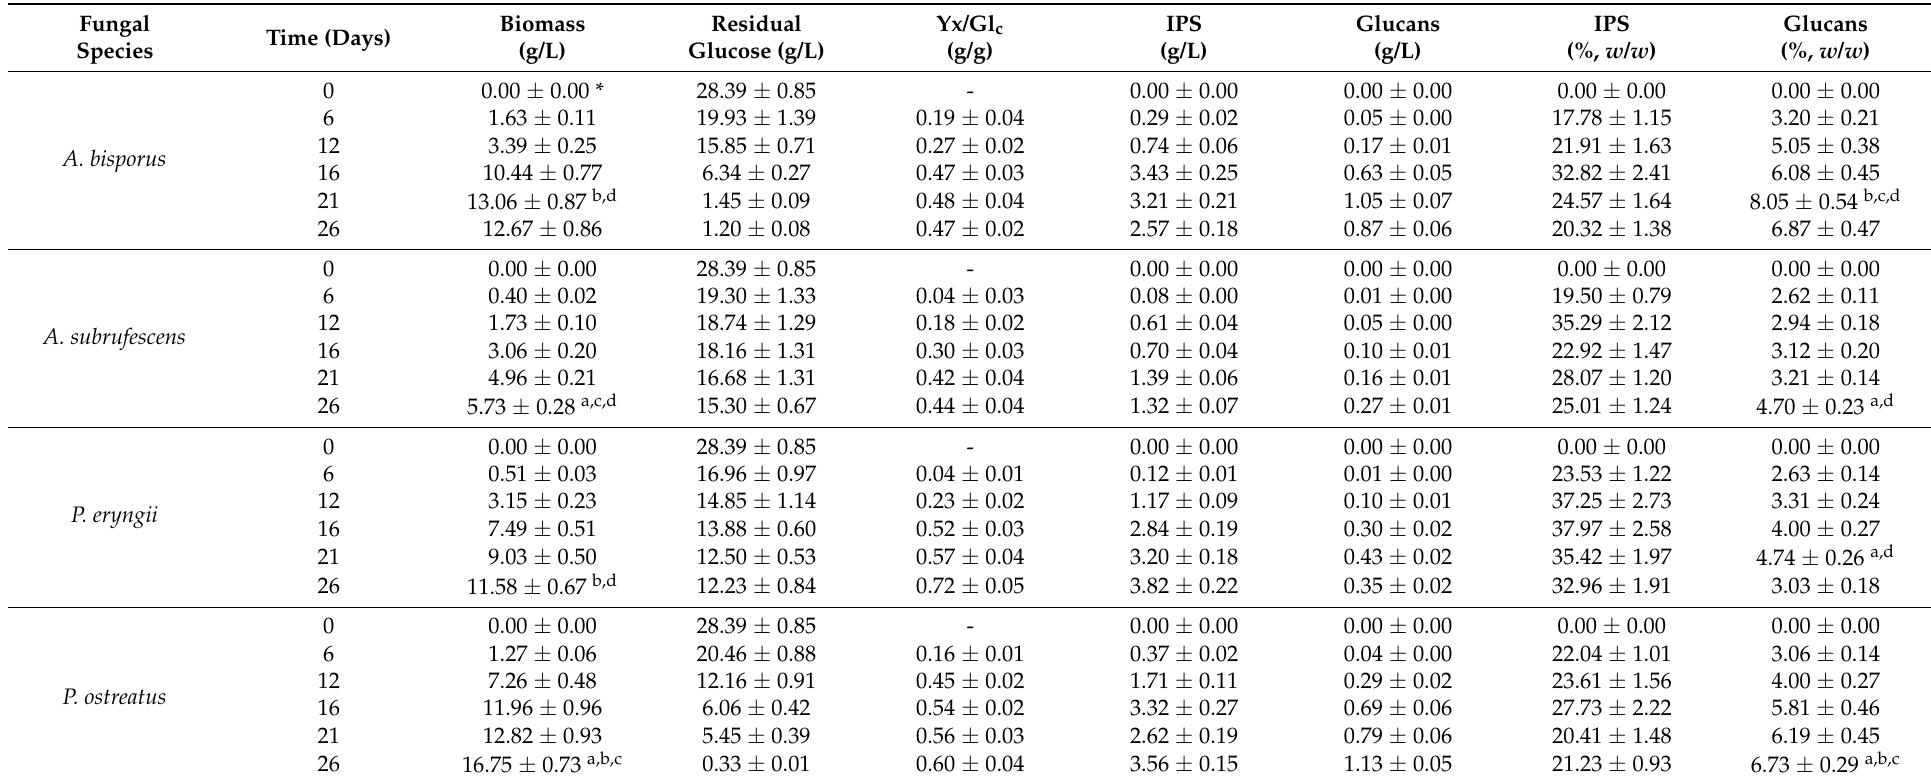
Table 1. Biochemical characteristics during the cultivation of A. bisporus (a), A. subrufescens (b), P. eryngii (c) and P. ostreatus (d) in agitated (120 ± 5 rpm) liquid cultures of C/N molar ratio 20, at 26 ± 1 ◦